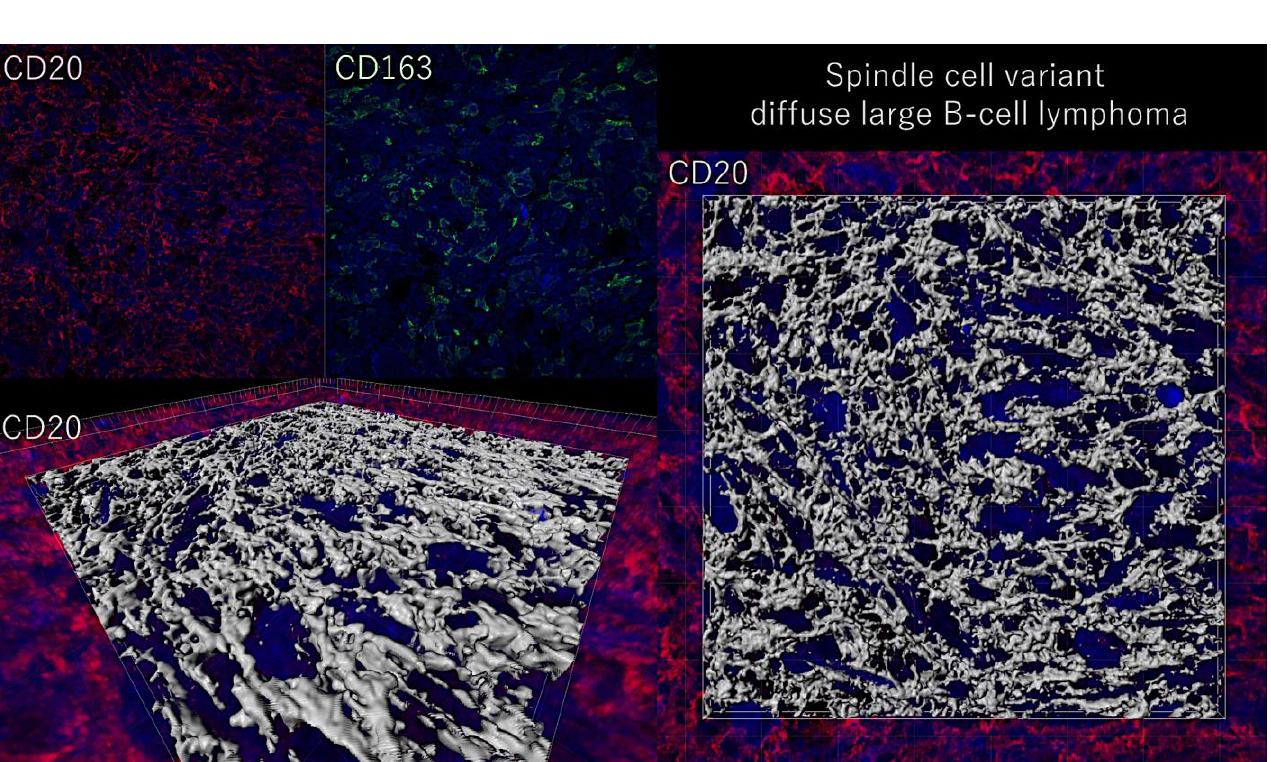
Figure A1. Three-dimensional rendering of spindle cell variant diffuse large B-cell lymphoma. The neoplastic CD20-positive B-lymphocytes of diffuse large B-cell lymphoma have spindle cell morphology, which is a very infrequent morphological variant.